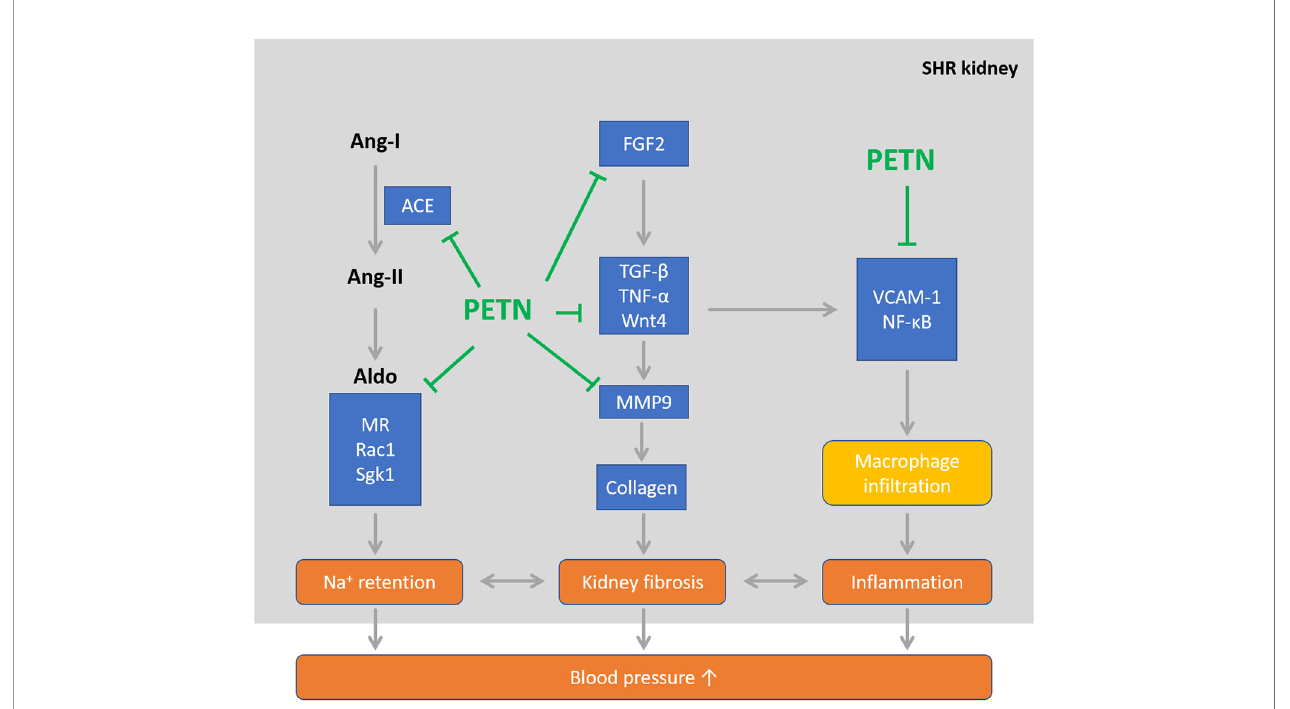
FIGURE 8 | Maternal pentaerythritol tetranitrate (PETN) treatment persistently reduces blood pressure in spontaneously hypertensive rats (SHR) offspring via improving kidney phenotype in young age. PETN treatment could be important in improving the renal-cardiovascular system by its effect in fetal reprogramming via epigenetics modi fi cations in early remodeling of